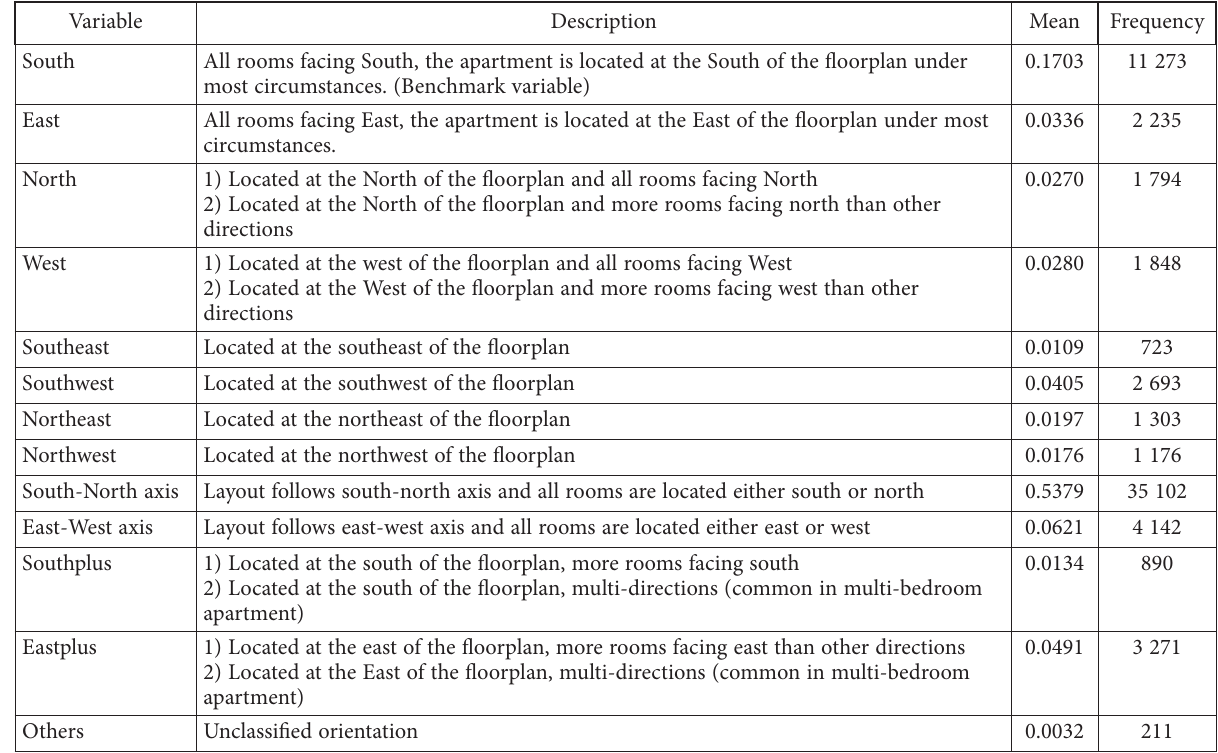
Table 2. Classification of orientation